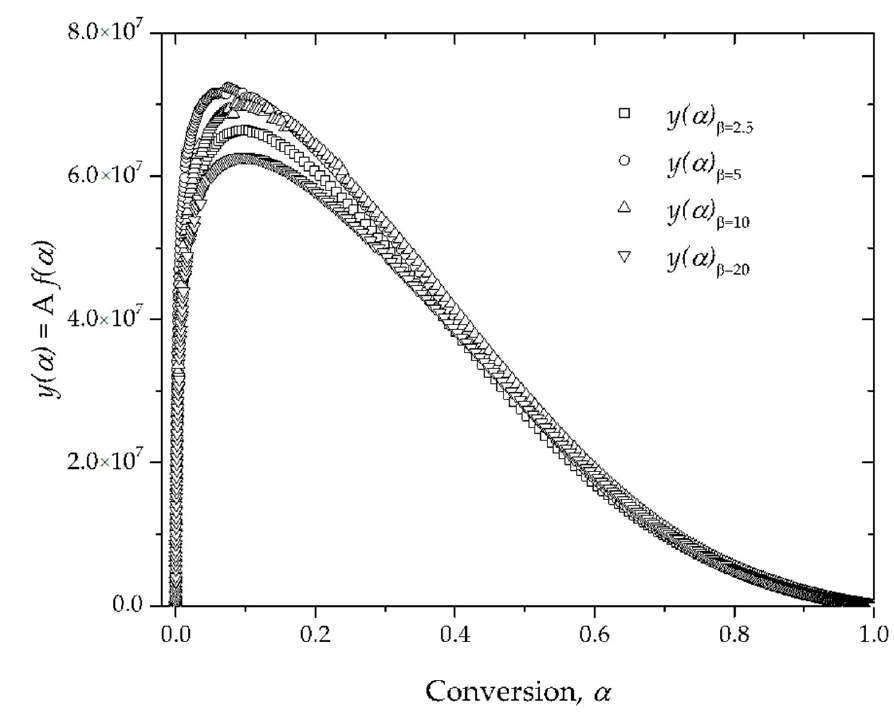
Figure 9. Calculated y ( α ) plots as a function of the conversion α , corresponding to the crosslinking of a partially bio-based epoxy resin for different heating rates.